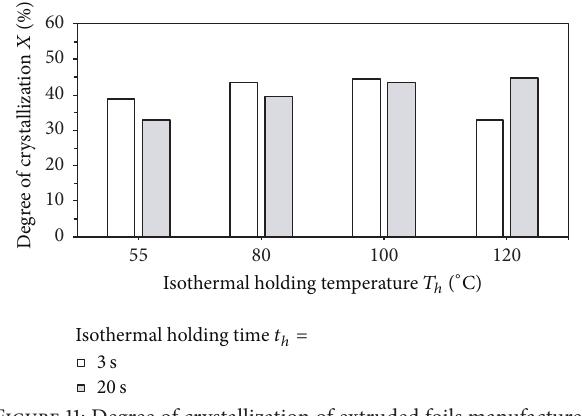
Figure 11: Degree of crystallization of extruded foils manufactured at different chill-roll temperatures and isothermal holding